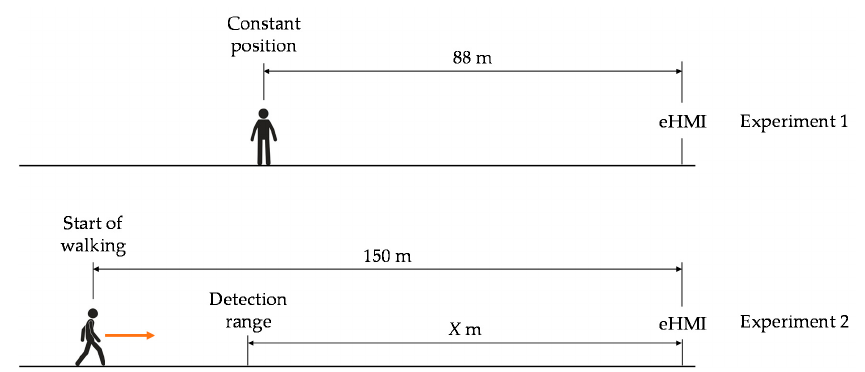
Figure 4. Experiment 1 evaluated the required content size for it to be legible from a distance of 88 m. Experiment 2 analyzed the human detection range ( X ) depending on content type and content color.